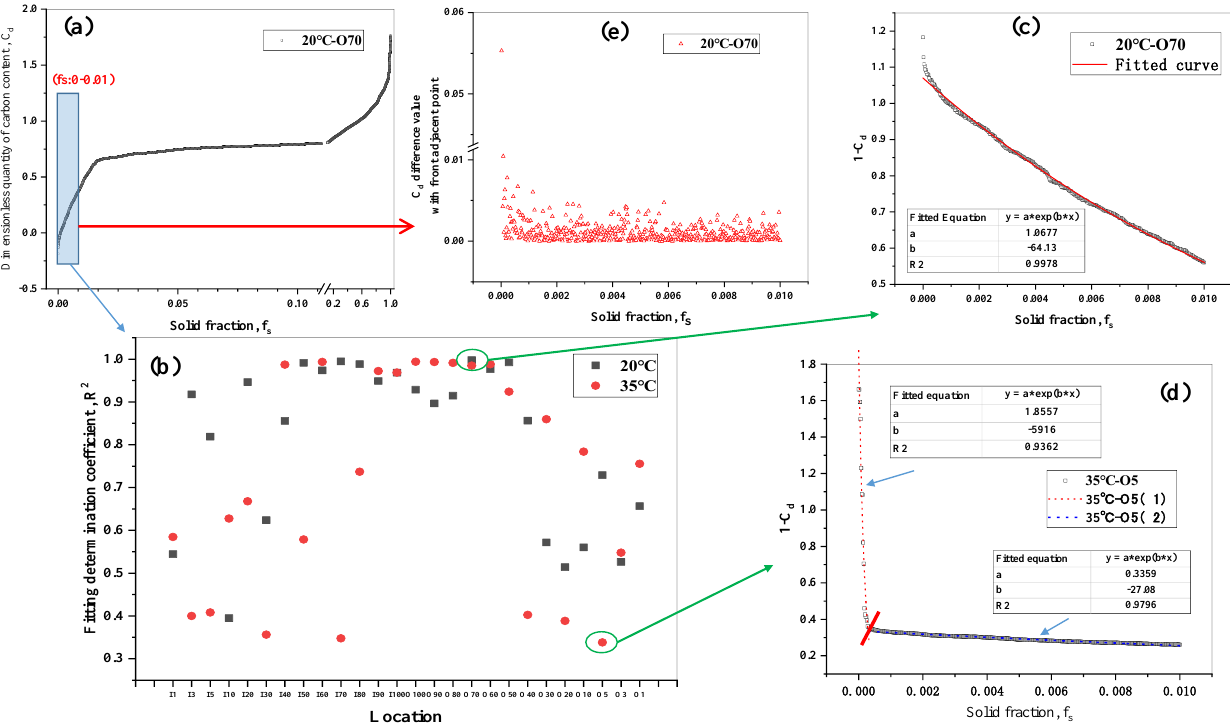
Figure 2. Effectivity of dimensionless element content in initial solidification of CC billets. ( a ) One typical distribution in the dimensionless quantity of carbon content (Cd) with solid fraction (O70 lo- cation of 20 ◦ C). ( b ) Fitting determination coefficients R2 during initial solidification ( f s : 0–0.01) at all locations. ( c ) The (1-Cd) distribution with solid fraction in initial solidification at the O70 location of 20 ◦ C. ( d ) The (1-Cd) distribution with solid fraction in initial solidification at O5 location of 35 ◦ C. The distribution was divided into two parts with a short red line, which shows a good fitness with the content distribution equation under no solute diffusion in solid and limited solute diffusion in liquid during initial solidification, the same as with that at the O70 location of 20 ◦ C. ( e ) A typical distribution of Cd difference, which is with a front adjacent point during initial